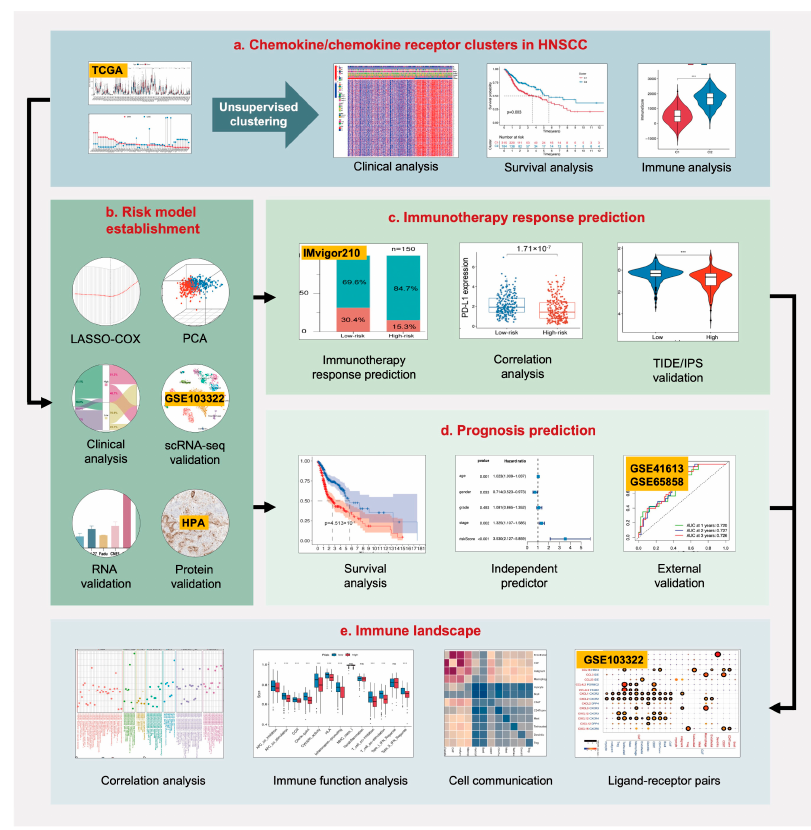
Figure 1. The workflow of our research.